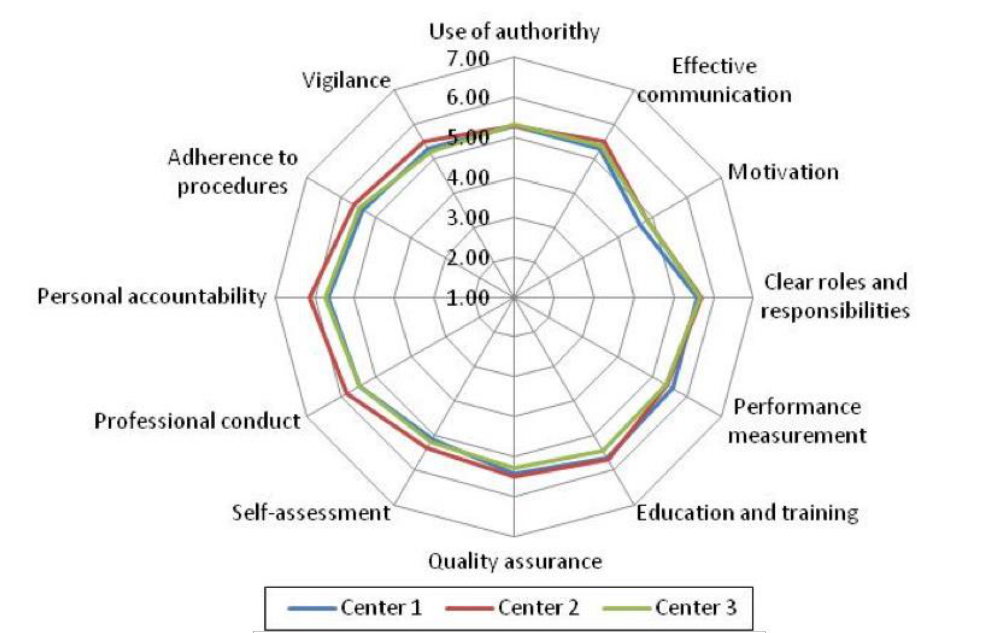
Figure 6. Scores of twelve characteristics surveyed for three